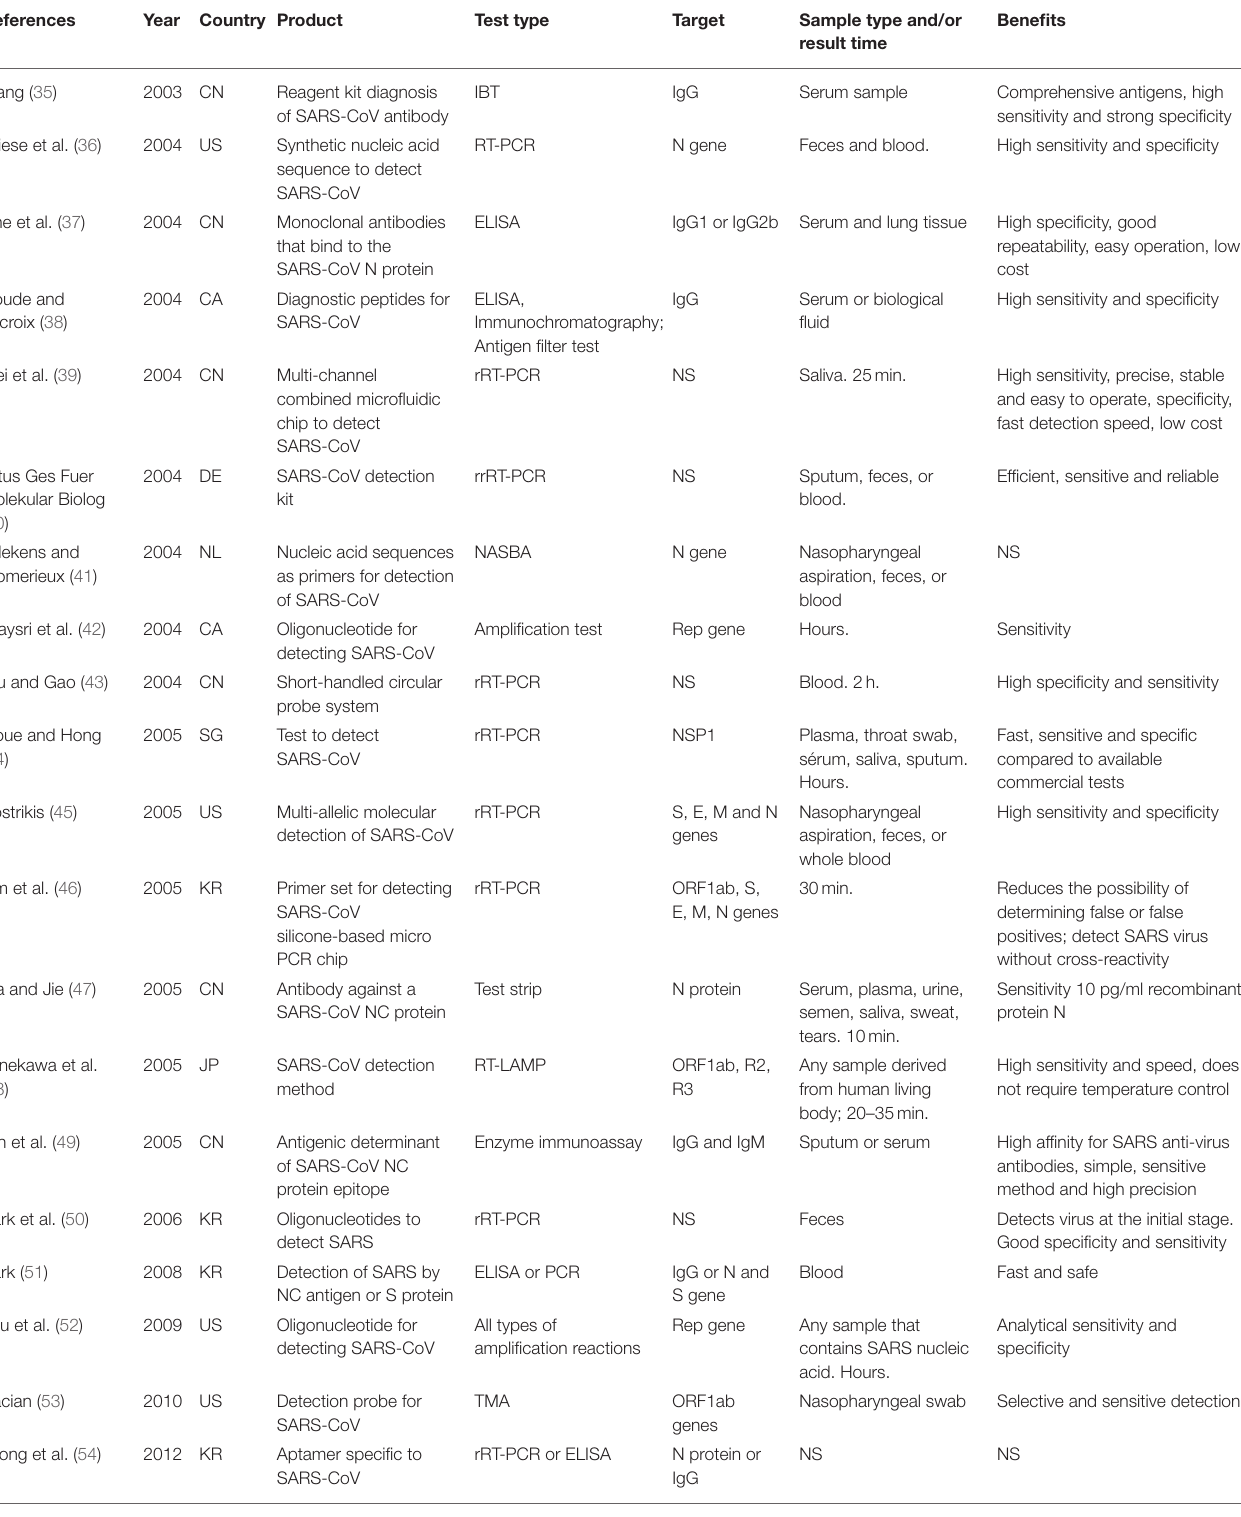
TABLE 1 | Published patents of SARS and MERS coronavirus